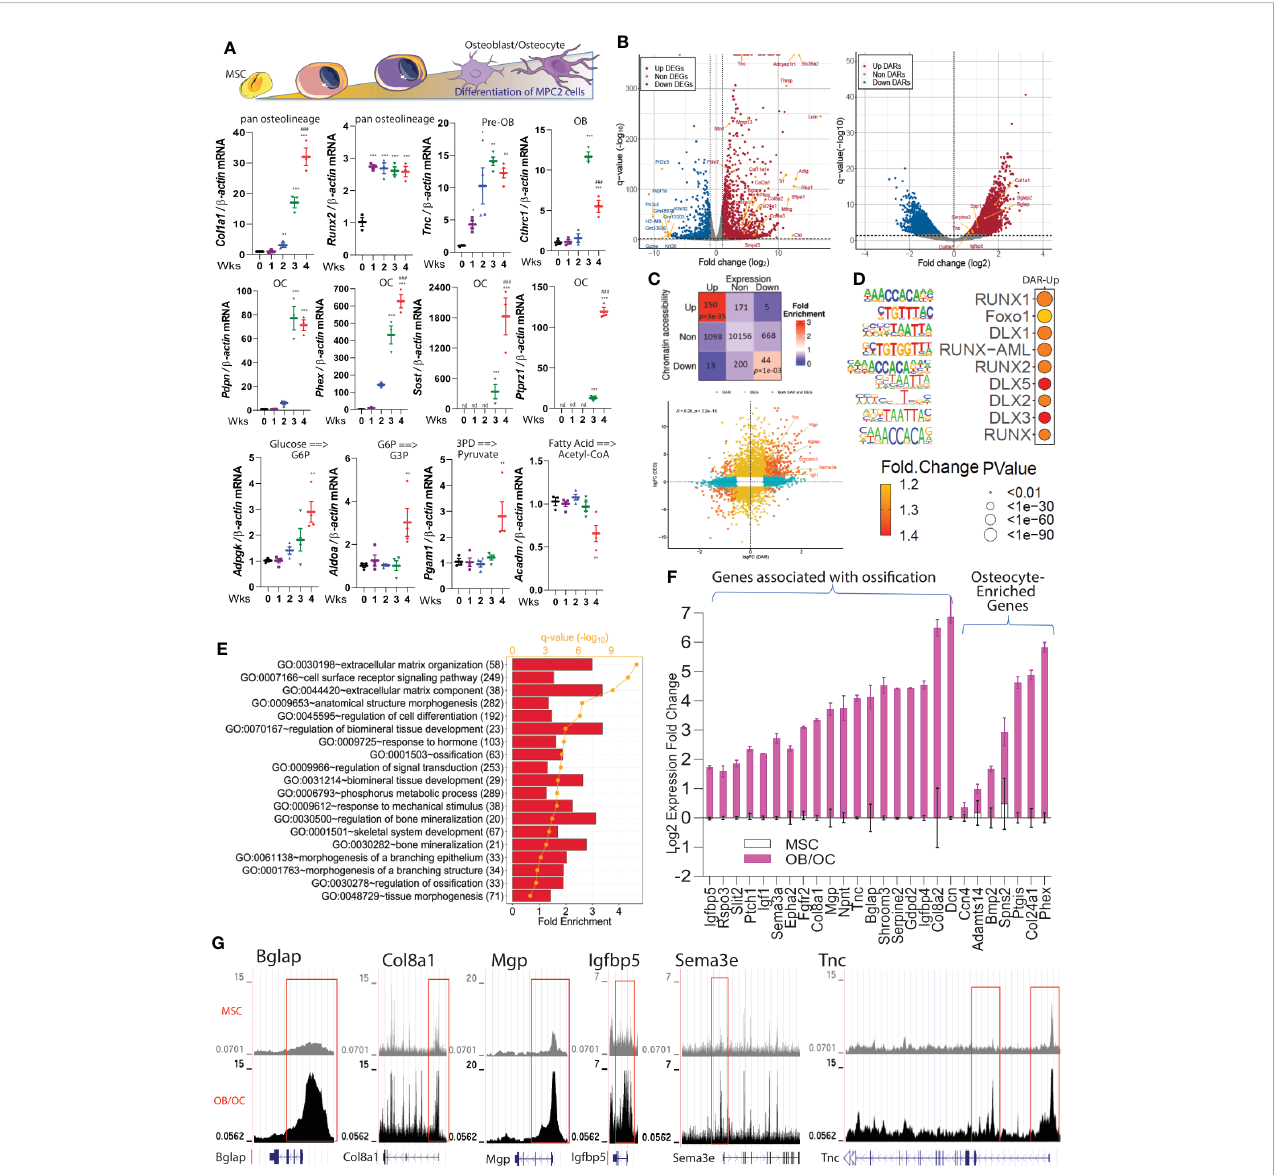
FIGURE 3 Molecular markers associated with osteoblast/osteocyte differentiation. (A) -top. Schematic representing cell differentiation from MSCs to osteoblasts/ osteocytes. (A) -lower. Col1a1 , Runx2, Tnc, Cthrc1, Pdpn, Phex, Sost, Ptprz1, Adpgk, Pgam1, Aldoa , and Acadm mRNAs were analyzed in MPC2 cells during osteogenic differentiation over the course of 1-4 weeks and normalized to b -actin. Data are represented as mean +/- standard deviation. *p<0.05, **p<0.01, and ***p<0.001 compared to Control (0 Wks). ### p<0.001 compared to 3 Wks. nd, not detected. (B) Volcano plots derived from the bulk RNAseq (left) and ATACseq datasets (right) show the signi fi cant alterations of gene expression and chromatin accessibility detected in differentiated 3 x 3 matrix heatmap highlights the number of genes with differentially accessible regions (DARs), or differentially expressed genes (DEGs), or both DARs and DEGs when compared differentiated versus undifferentiated cells. (C) lower. Integration of ATACseq and RNAseq data exhibited a higher correlation between genome-wide chromatin accessibility changes (x-axis) and gene expression alterations (y-axis). (D) Selected motifs of more open regions of the genome in differentiated cells versus undifferentiated cells using the ATACseq. (E) Functional enrichment analysis using the Database for Annotation, Visualization and Integrated Discovery (DAVID) on upregulated DEGs with more open DARs identi fi ed biological pathways that were induced during osteogenic differentiation (numbers in parenthesis are gene counts). (F) Representative mRNA expression of upregulated genes in differentiated versus undifferentiated cells enriched in cell morphogenesis and ossi fi cation. All the genes shown were signi fi cantly upregulated (false discovery rate, FDR < 0.05). The osteocyte genes identi fi ed from the scRNAseq dataset in Figure 1J were con fi rmed to be signi fi cantly upregulated in osteoblasts/osteocytes cells versus control undifferentiated MPC2 cells. (G) Representative ATACseq peaks of undifferentiated cells (top track in gray) compared to differentiated cells (osteoblasts/osteocytes bottom track in black) are